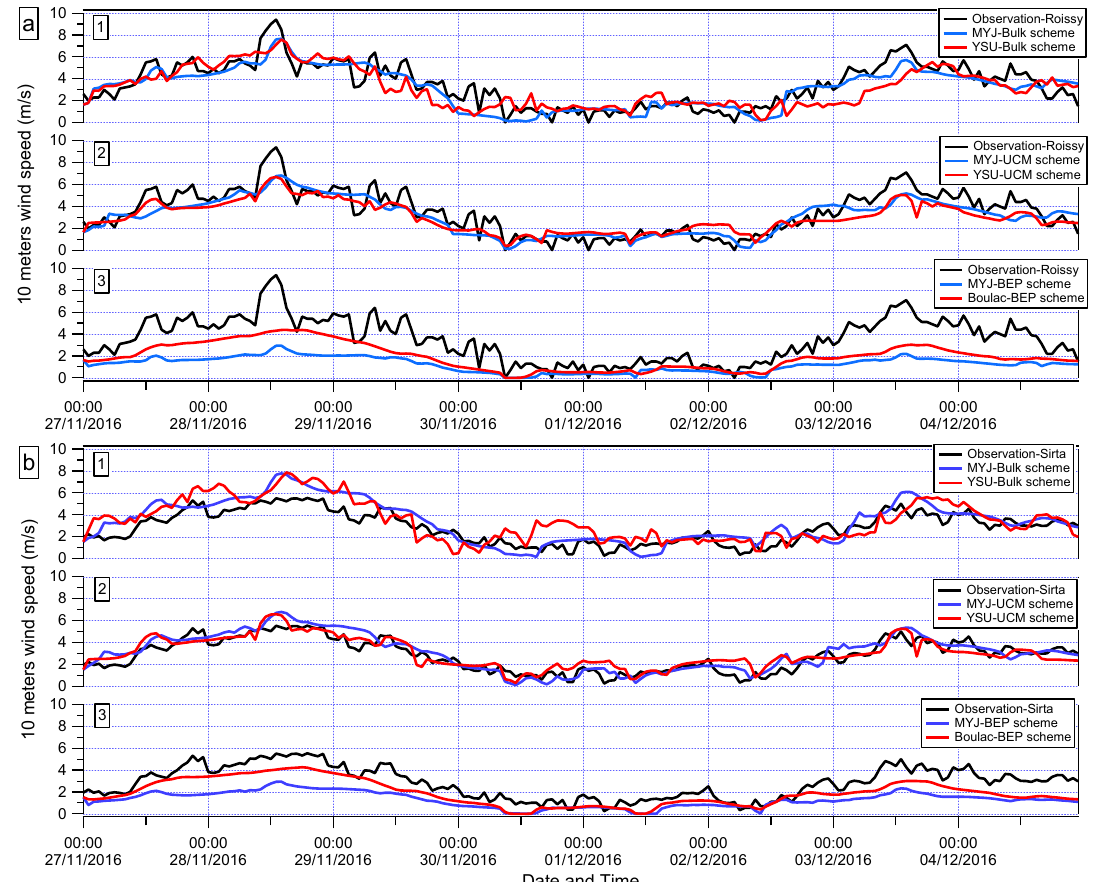
Figure 16. Time series between the observed and modelled W10: ( a ) and ( b ) represent Roissy and Sirta station, respectively; 1, 2, and 3 represent each PBL scheme coupled with each urban canopy scheme. Table 3. Statistics of surface variables: mean bias (MB) and mean linear correlation coefficient (R) between the simulations and observations of 2 m temperature (T2) and 10 m wind speed (W10) at Roissy and Sirta stations. Roissy Sirta T2 W10 T2